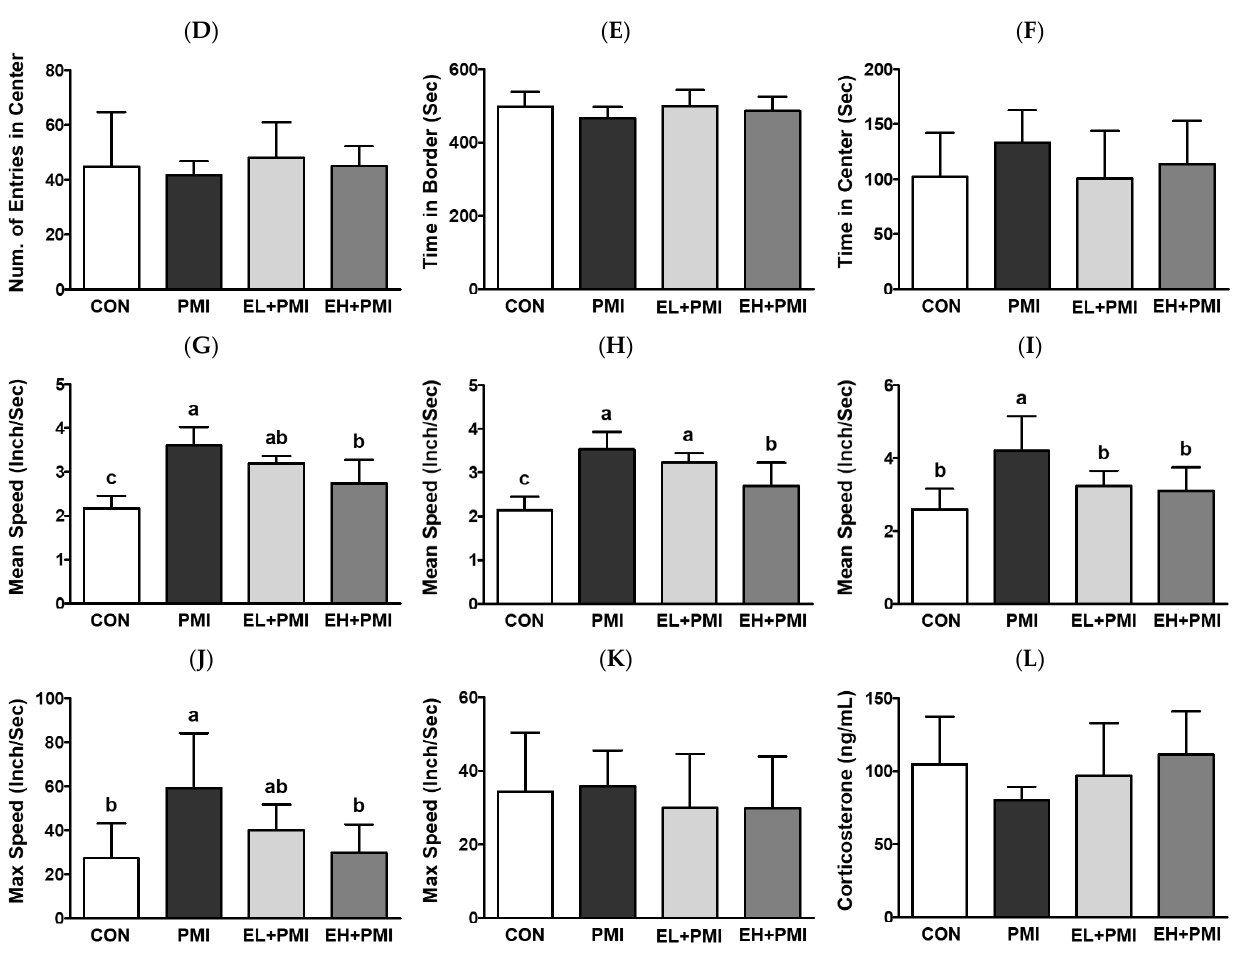
Figure 6. Open field test results and serum corticosterone levels after ellagic acid (EA) pretreatment and particulate matter (PM) instillation. C57BL/6 mice were orally pretreated with ellagic acid (EL; 20 mg/kg or EH; 100 mg/kg) for 7 days, and then PM (5 mg/kg) was intratracheally administrated for 7 days with or without ellagic acid pretreatment: ( A ) total distance moved, ( B ) distance moved in border, ( C ) distance moved in center, ( D ) number of entries into center, ( E ) time spent in border, ( F ) time spent in center, ( G ) the total mean speed, ( H ) mean speed in border, ( I ) mean speed in center, ( J ) max speed in border, ( K ) max speed in center of mice within 10 min of the open field test, and ( L ) serum corticosterone measured 1 day after the OFT. Values represent the mean ± standard deviation (SD) for each group ( n = 8 ). Data passed the D’Agostino and Pearson omnibus test; one-way ANOVA with Tukey’s post hoc test was applied. Lowercase letters indicate significant differences. p < 0.05.